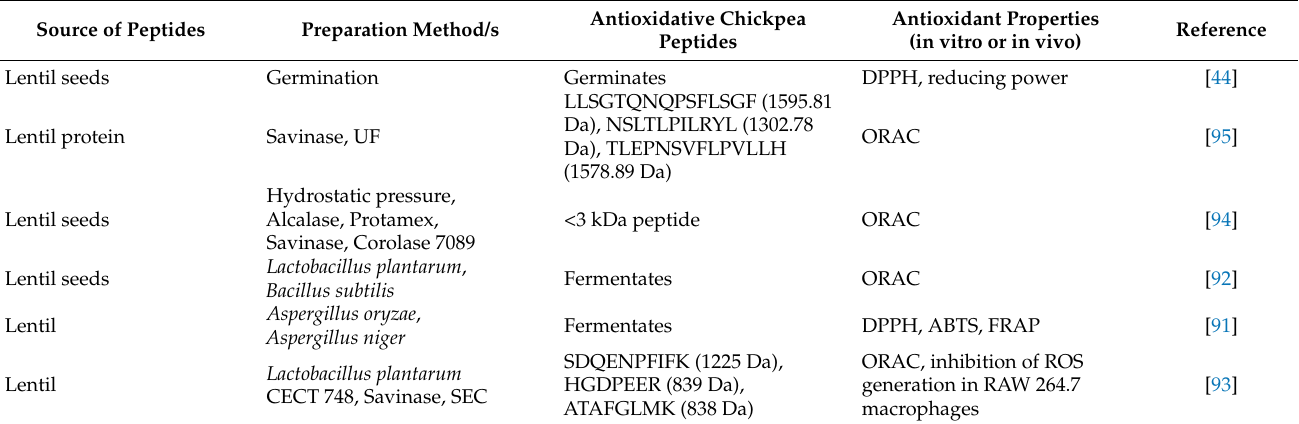
Table 3. Antioxidant properties of hydrolysates and peptides from lentil protein. Source of